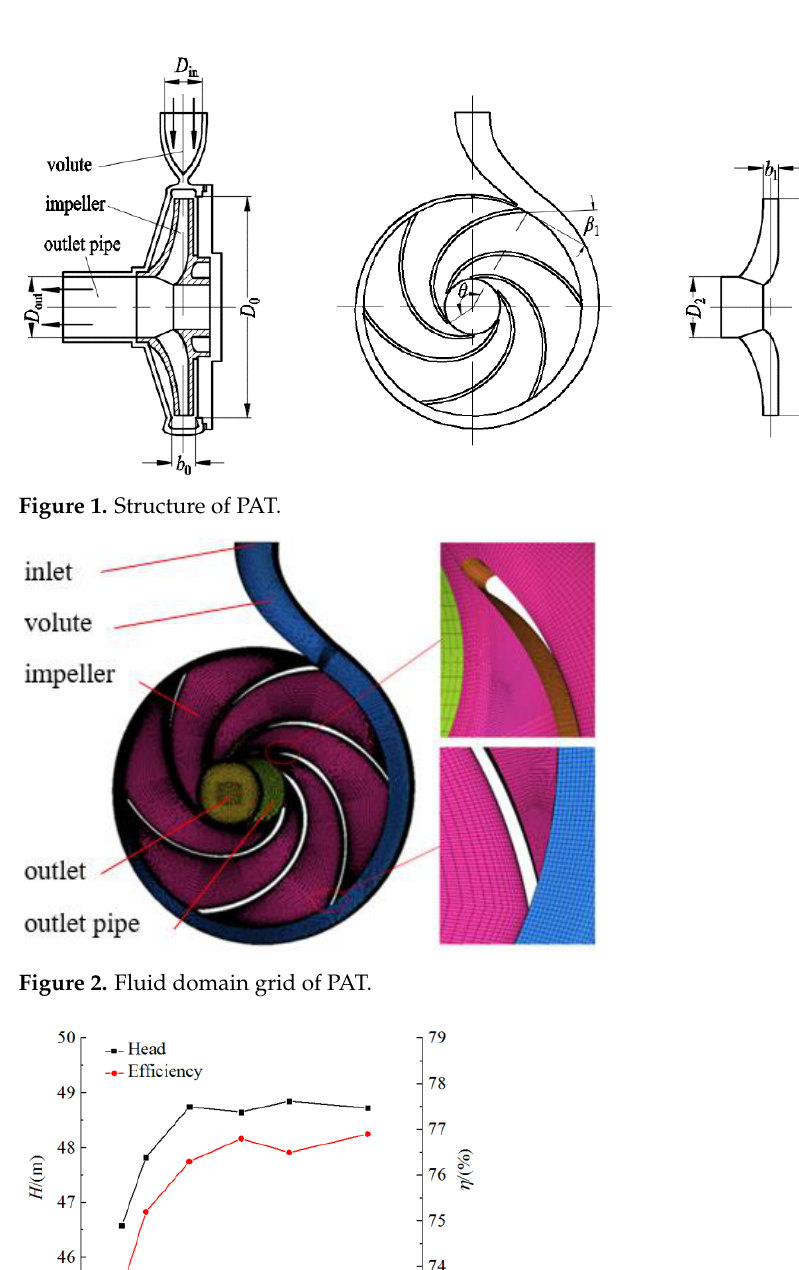
Figure 2. Fluid domain grid of PAT. Figure 3. Check of grid independence at IGVF of 0.15. Figure 3. Check of grid independence at IGVF of Figure 3. Check of grid independence at IGVF of 0.15.